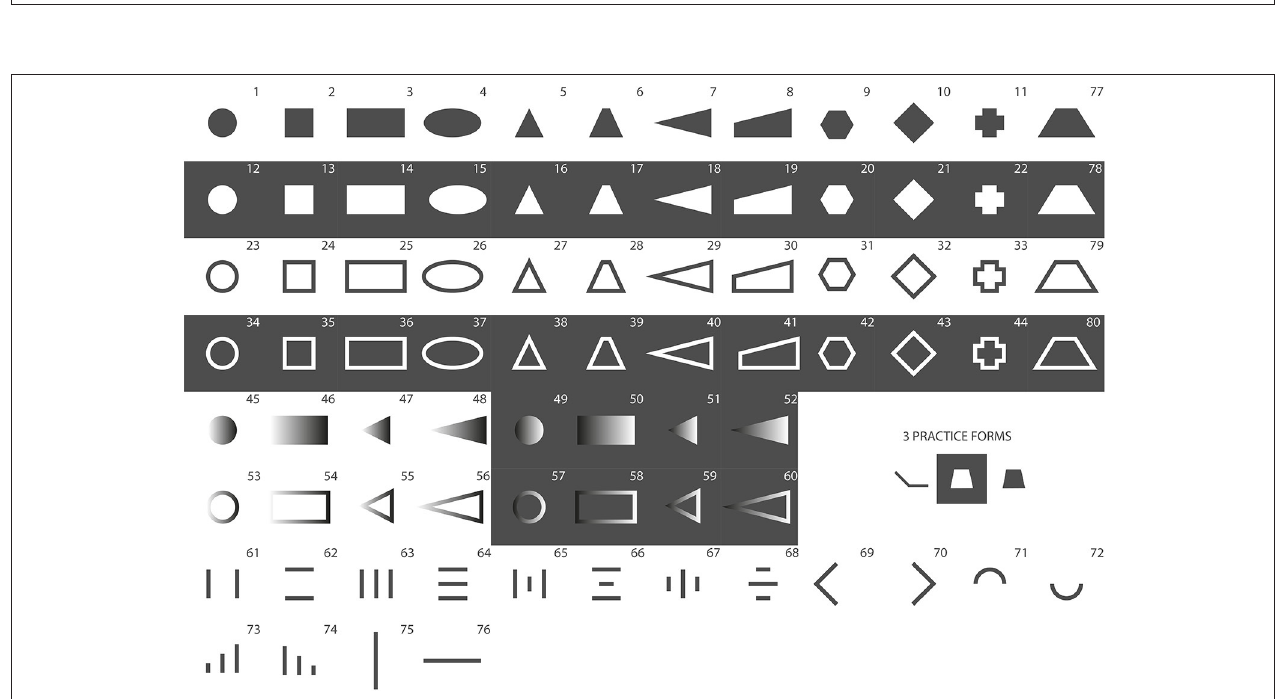
FIGURE 3 | These stimuli present the initial set of 80 stimuli, which was used in Pre-Study 1. Gray areas equal protruded (non-engraved), and white equals laser-engraved areas.